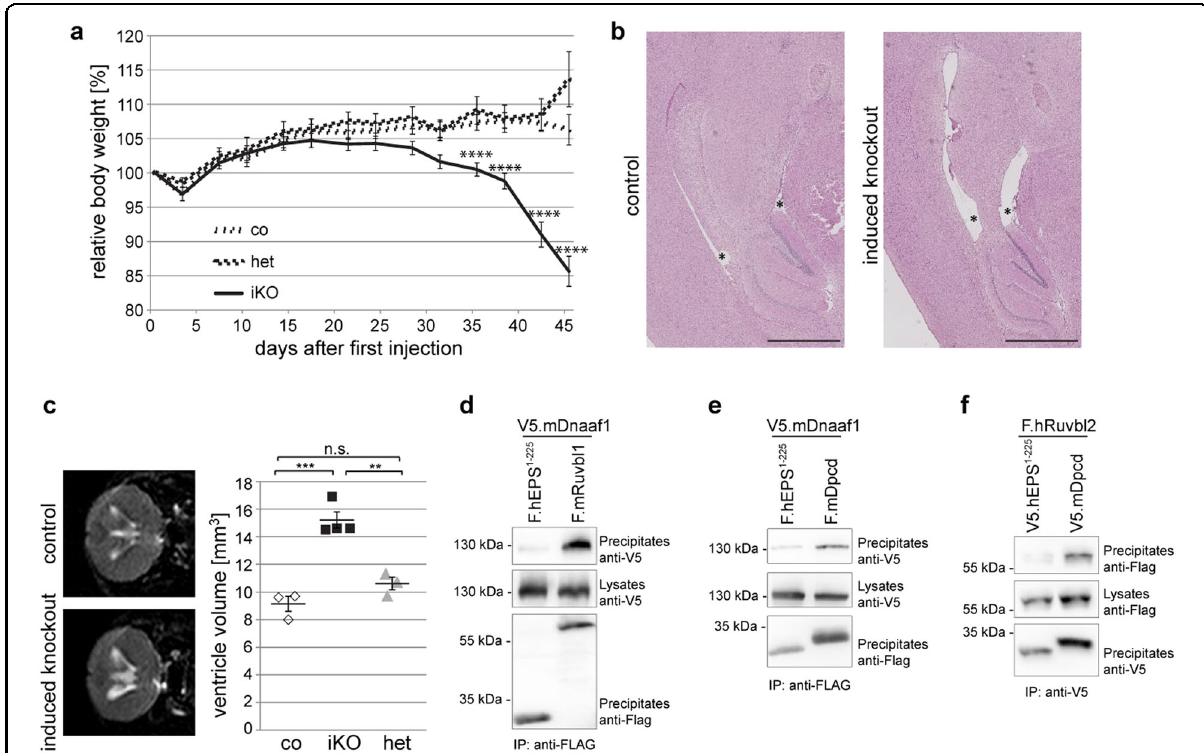
Fig. 5 Ruvbl1 deletion in multiciliated cells results in hydrocephalus in mice. a Induction of Ruvbl1 knockout (iKO; n = 34) in multiciliated cells by tamoxifen injection ( “ day 0 ” ) led to signi fi cant weight loss compared with control (co; n = 31) or heterozygous (het; n = 8) littermates. Repeated measures two-way ANOVA (F(26,906) = 8.821, p < 0.0001) with Bonferroni-corrected post hoc analyses (**** p < 0.0001). b Histological PAS staining of brain tissue showing that the induction of Ruvbl1 knockout in ependymal cells led to widening of brain ventricles (asterisks). Scale bars: 1 mm. c MRI scan of brain showing signi fi cantly increased ventricle volumes in the induced knockout mice (iKO; n = 4) compared with control (co; n = 3) or heterozygous (het; n = 3) littermates (F(2, 7) = 34.47, p = 0.0002; Tukey ’ s post hoc *** p < 0.001). Mean ± SEM. d Dnaaf1 speci fi cally co-precipitated with Ruvbl1, but not with the control protein. FLAG-tagged Ruvbl1 or control protein (EPS) was precipitated, and precipitates were analyzed for co- precipitating V5-tagged Dnaaf1. e Dnaaf1 speci fi cally co-precipitated with Dpcd, but not with a control protein. FLAG-tagged Dpcd or control protein (EPS) was precipitated, and precipitates were analyzed for co-precipitating V5-tagged Dnaaf1. f Ruvbl2 speci fi cally co-precipitated with Dpcd, but not with a control protein. FLAG-tagged Dpcd or control protein (EPS) was precipitated, and precipitates were analyzed for co-precipitating V5-tagged